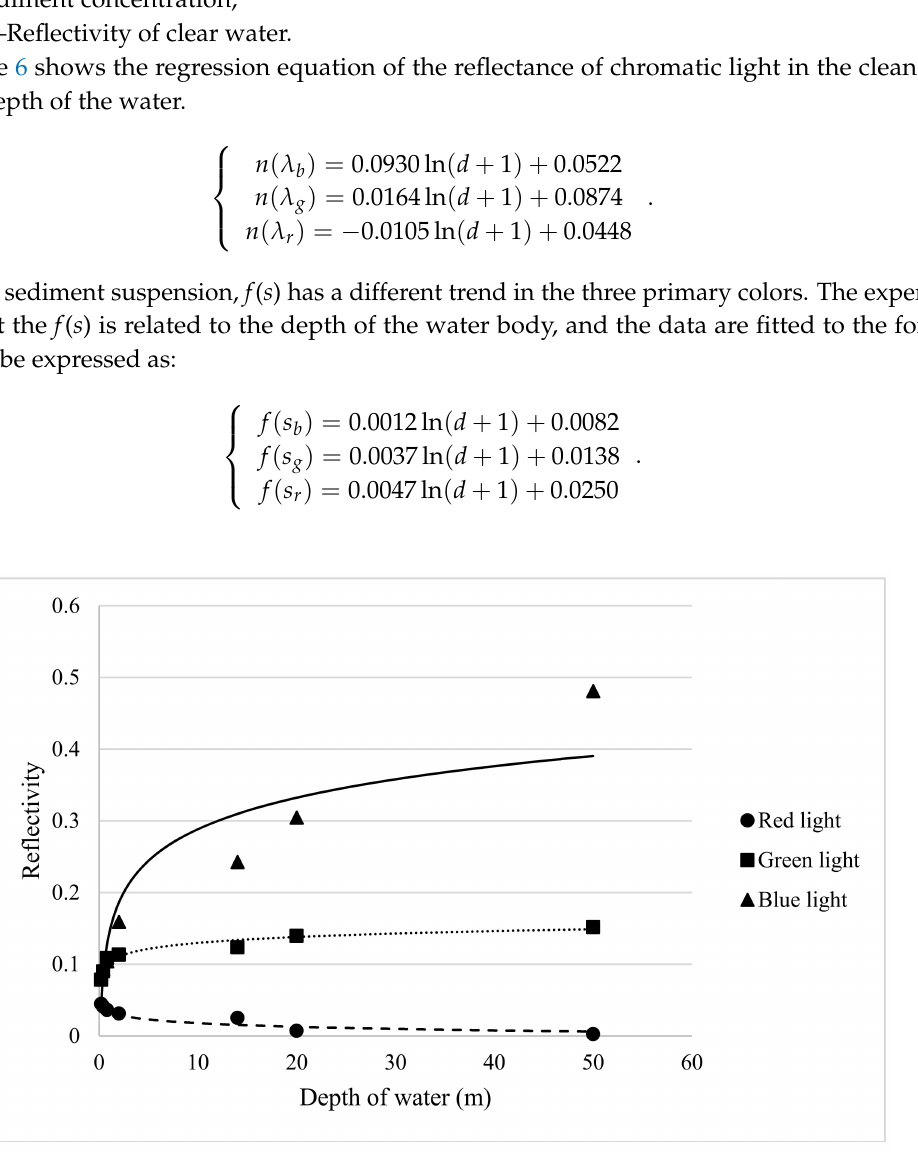
Figure 6. The reflectance of color and trichromatic wavelength varies with the water